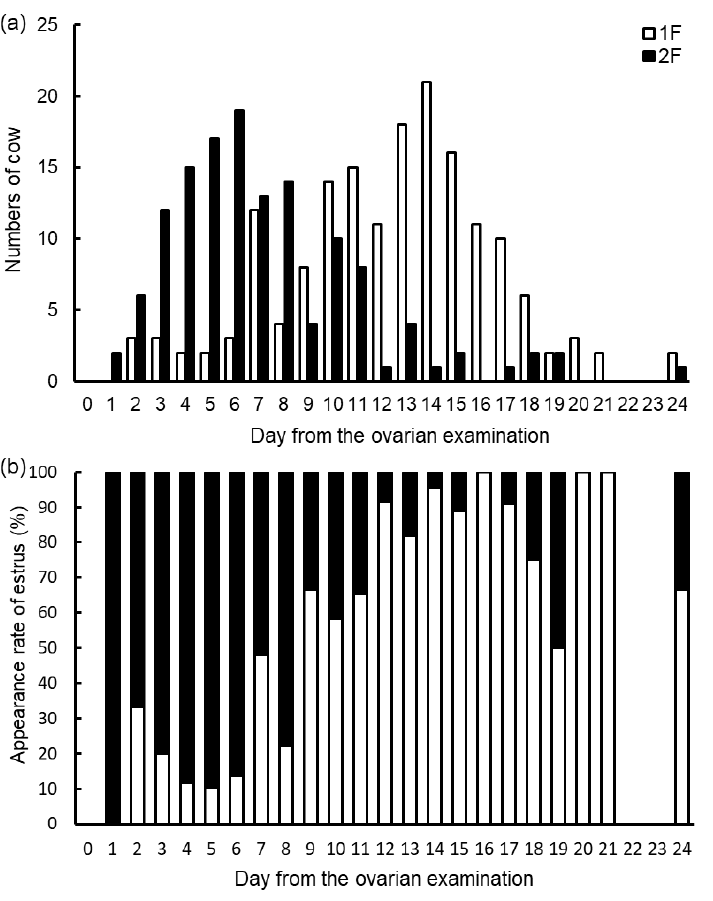
Figure 4. Distribution of numbers and appearance rates of detected estrus in 1F and 2F after the ovarian examination, respectively. The distribution day of the number of detected estruses in 1F